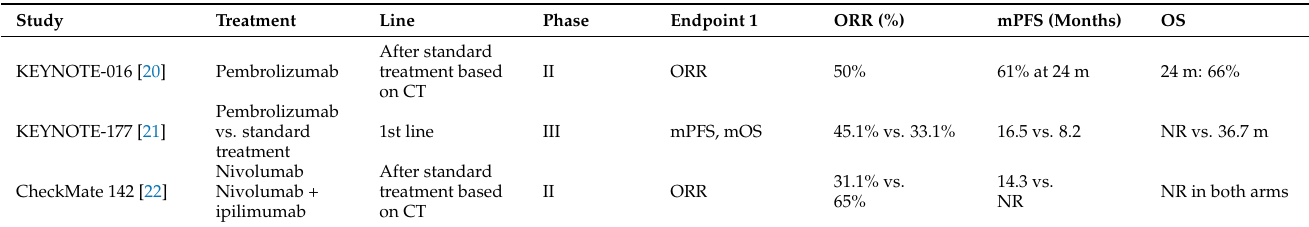
Table 1. Clinical trials that evaluated ICIs in MSI mCRC and got the approval from